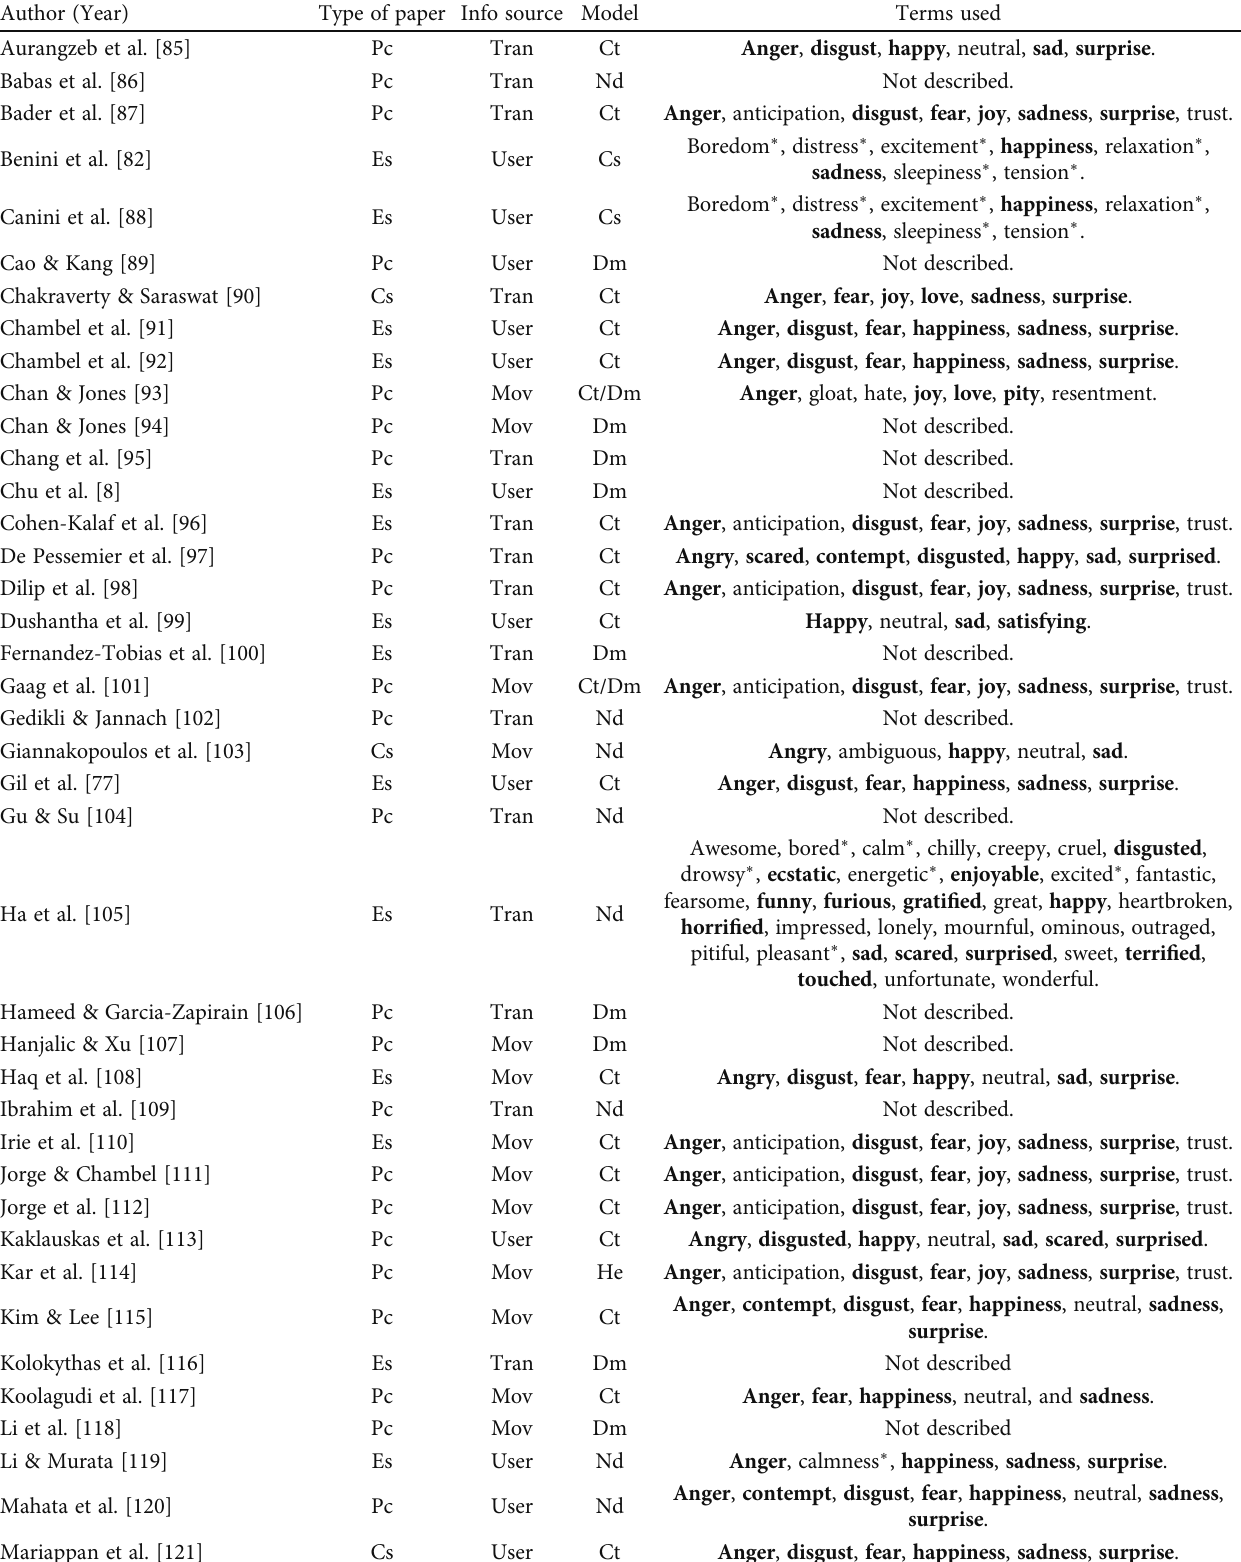
Table 3: List of documents selected for the fi nal analysis of the scoping